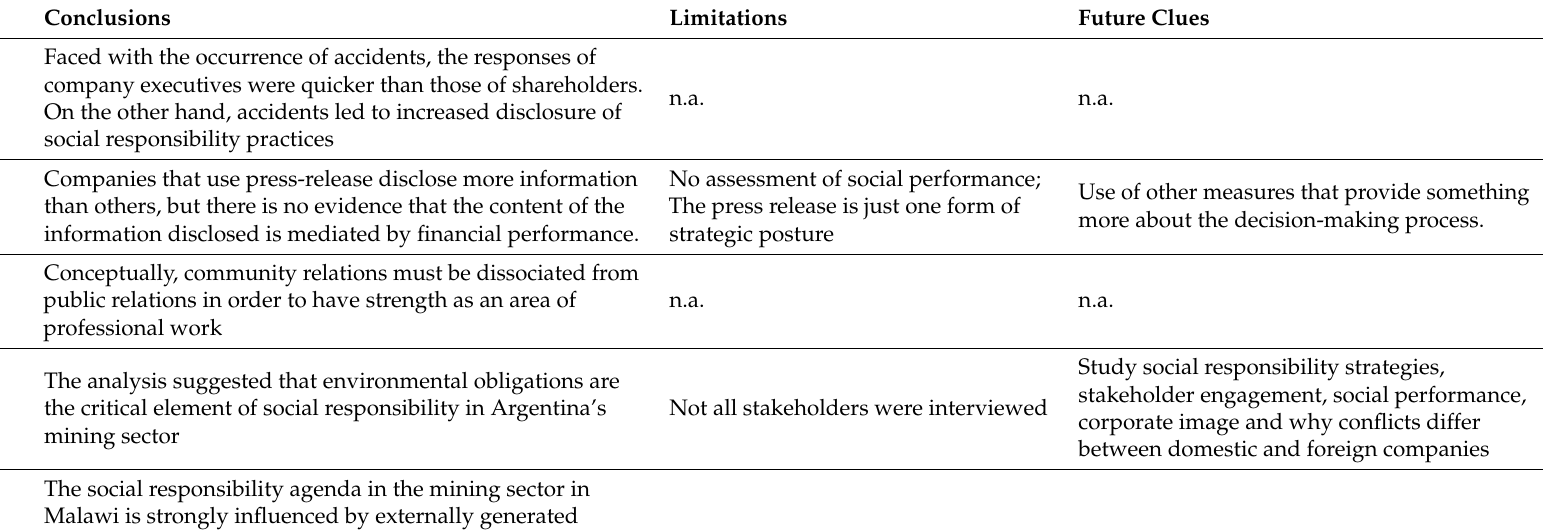
Table 4. Contributions of the articles (n =